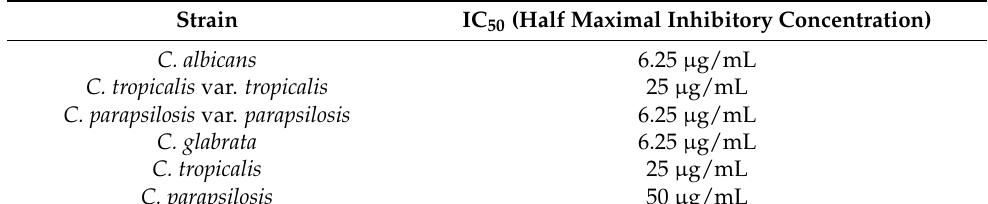
Table 1. A. triphylla var. japonica extracts inhibited biofilm formation of Candida spp. IC 50 value.